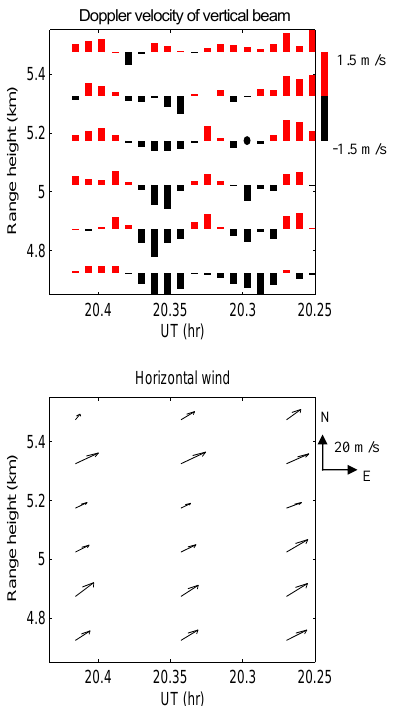
Figure 7: (upper) mean Doppler velocity estimated from the Doppler spectrum of 64 data points of the vertical beam, and (lower) horizontal wind derived from full-correlation analysis of spaced antenna with 512 data points.